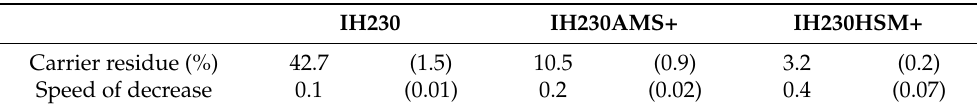
Table 6. Results of the AJS adhesion strength screening of all prepared adhesive mixtures. n = 3, SD in parentheses.